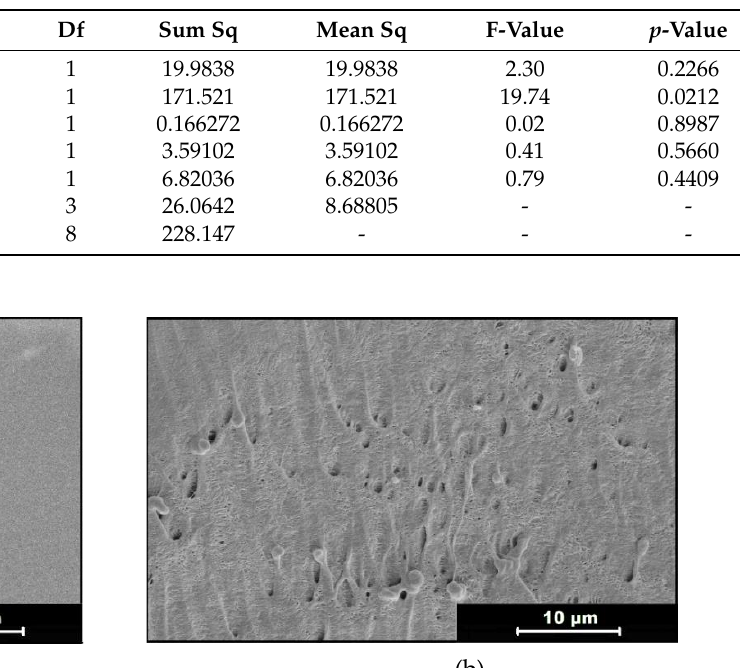
Figure 7. Release profiles including the different phases of the release process from the PLA filaments impregnated with ketoprofen under different conditions.